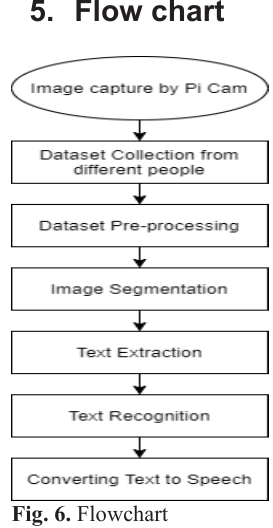
Fig. 6. Flowchart